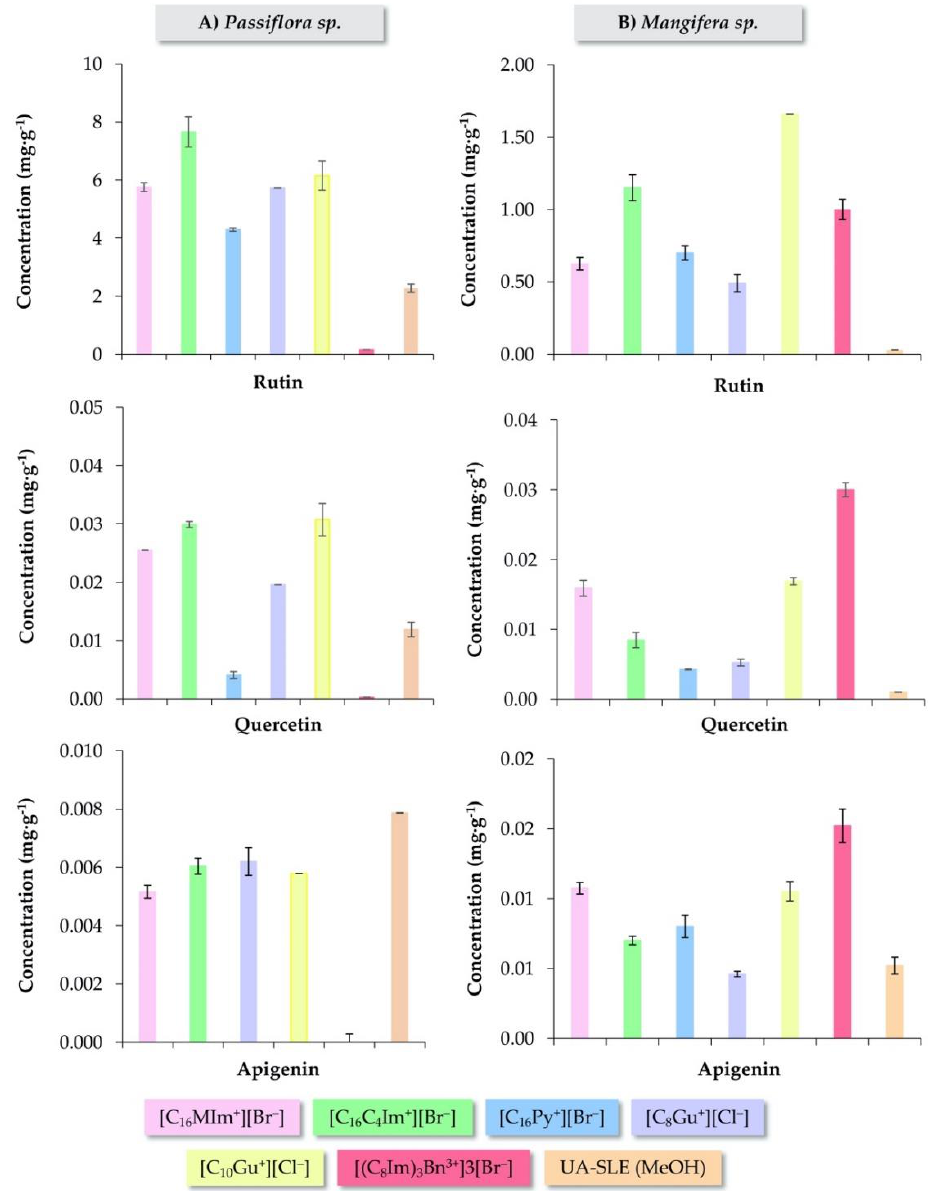
Figure 2. Extraction performance of the IL-MA-SLE-HPLC-PDA method when using different IL-based surfactants for the determination of rutin, quercetin and apigenin, in Passiflora sp. (PS032) and Mangifera sp. (Sweet tart) leaves, respectively. Extractions were performed in triplicate under the optimum experimental conditions described in Section 2.3.3.